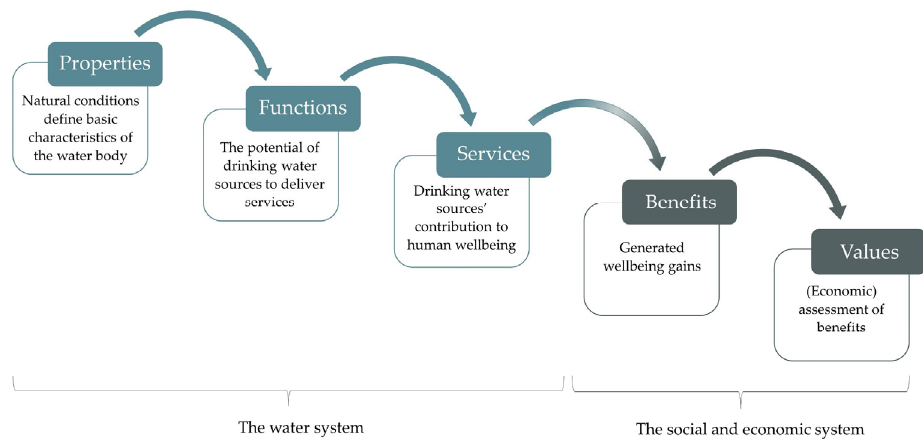
Figure 1. The CICES cascade model based on [5] applied to water systems.